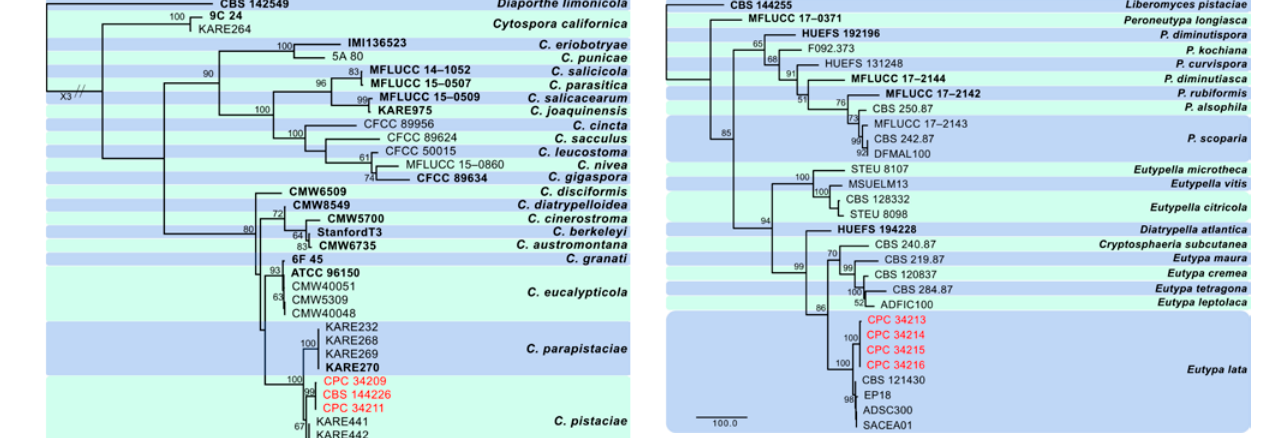
Figure 3. The first of four equally most parsimonious trees obtained from a heuristic search of the combined ITS, and tub2 sequence alignments of species belonging to Eutypa and other genera of Dia- trypaceae. Bootstrap support values are shown at the nodes. The strains isolated in this study are shown in red and the scale bar rep- resents the number of changes. The tree was rooted to Liberomyces pistaciae (CBS